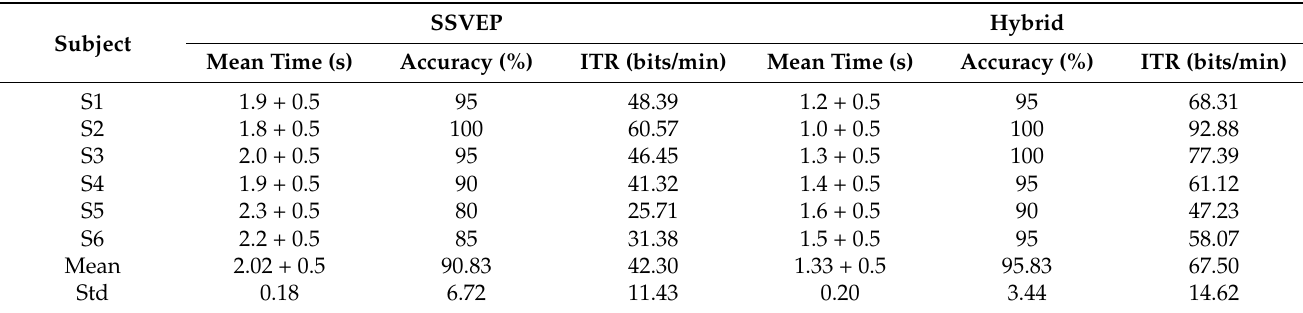
Table 2. Results of asynchronous online selection of threatening pedestrians by SSVEP-BCI and hybrid